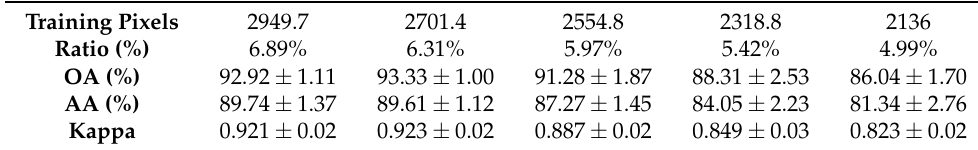
Table 10. Performance with different ratios of labeled pixels for training over PU dataset.